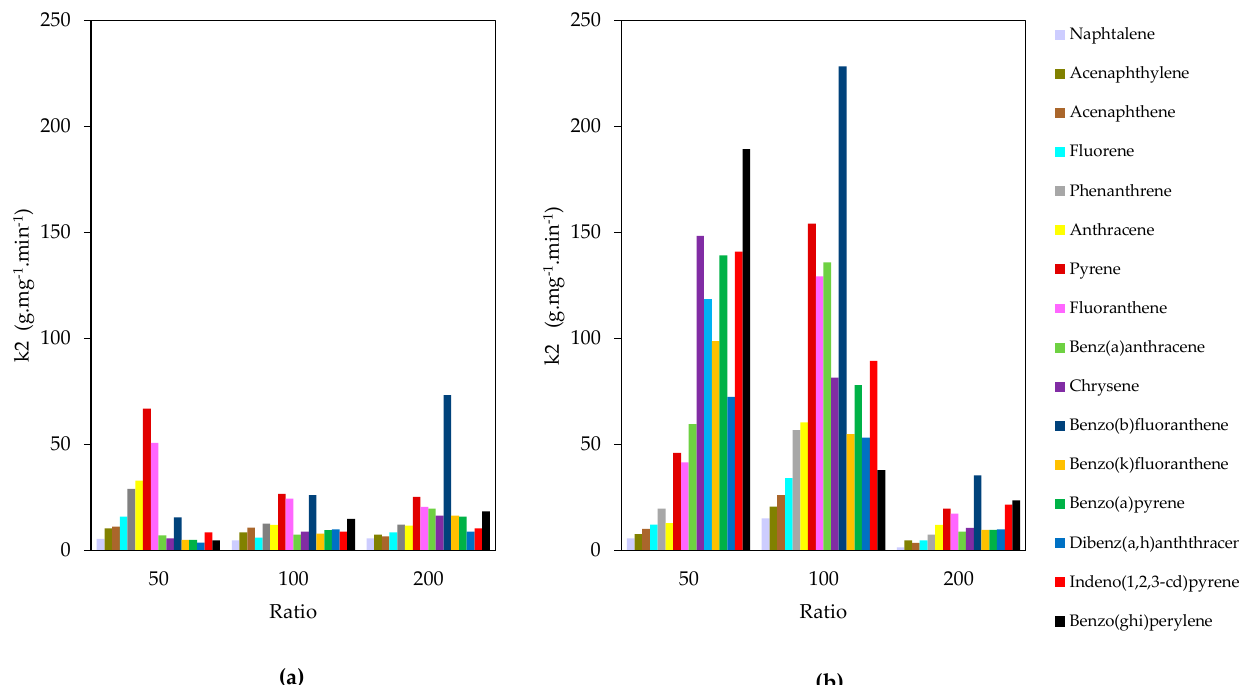
Figure 5. Pseudo-second order rate constant of PAHs adsorption by ( a ) (ZrO 2 ) x (VPA) and ( b ) (ZrO 2 ) x (PPA) samples (Zr/P ratio ( x ) = 50, 100, 200).